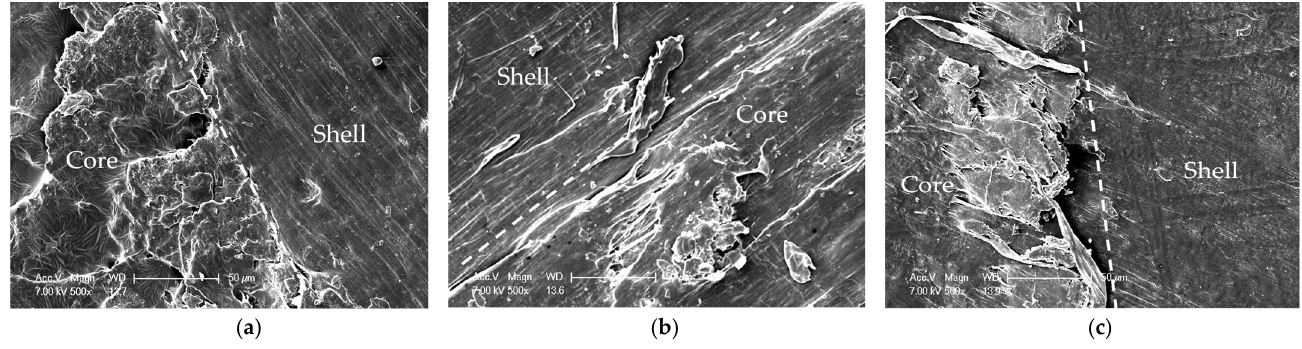
Figure 2. SEM micrographs of core–shell structured WPCs. ( a ) CSHDPE; ( b ) CS CA10; ( c ) CSCA25.